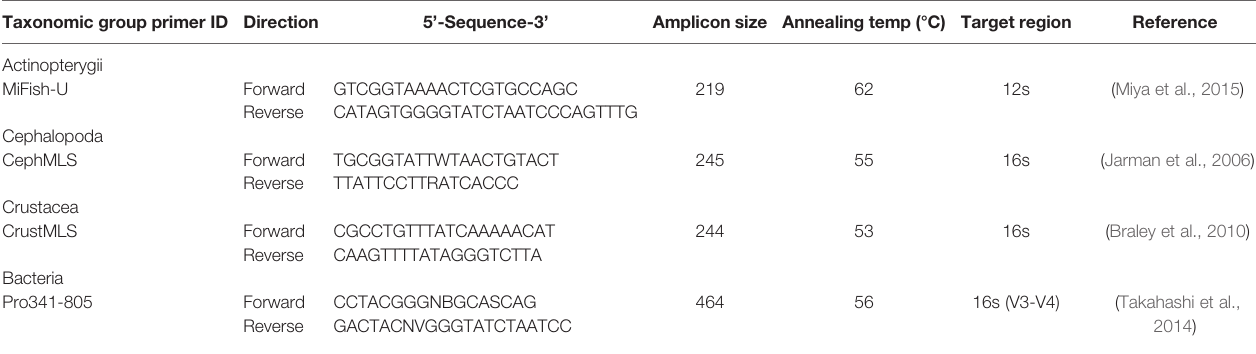
TABLE 1 | Selected DNA metabarcoding primers designed for actinopterygian, cephalopod, crustacean, and bacteria species. Taxonomic group primer ID